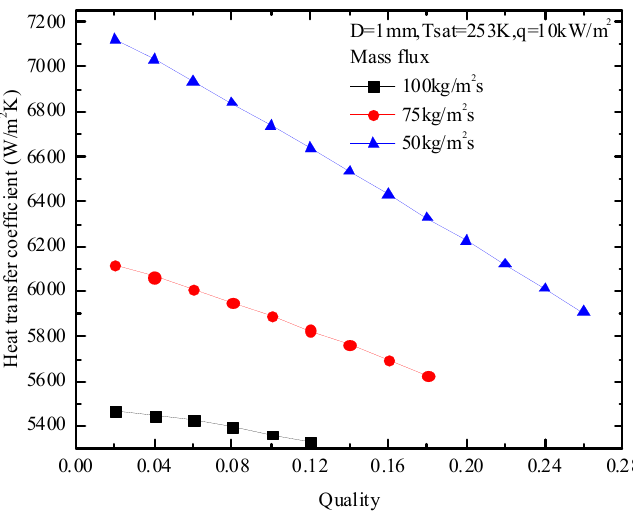
Figure 11. Effect of mass flux on heat transfer coefficient of azeotropic refrigerant.